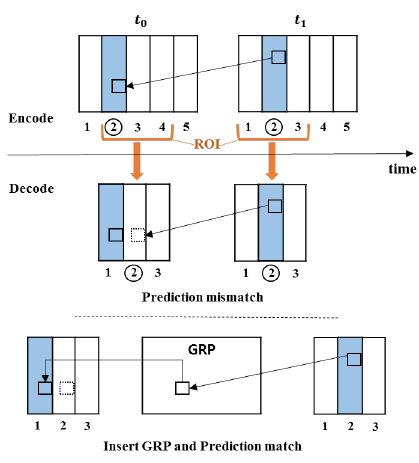
Figure 3. Prediction mismatch and GRP concept for solving a